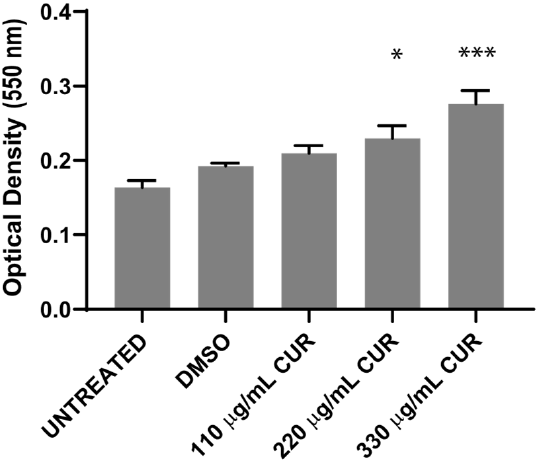
Figure 4. MTT reduction by S. enterica ser. Typhimurium treated with CUR, (* p < 0.05, *** p < 0.001) . 2.3. Virulence Factors are Upregulated by Curcumin.